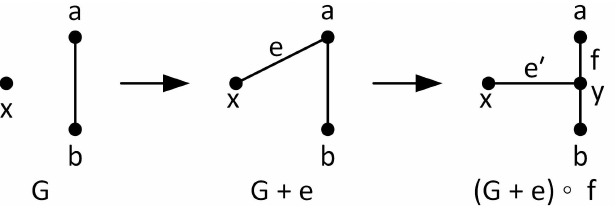
Figure 6. Operation D1 interpreted as an edge addition followed by a vertex split.